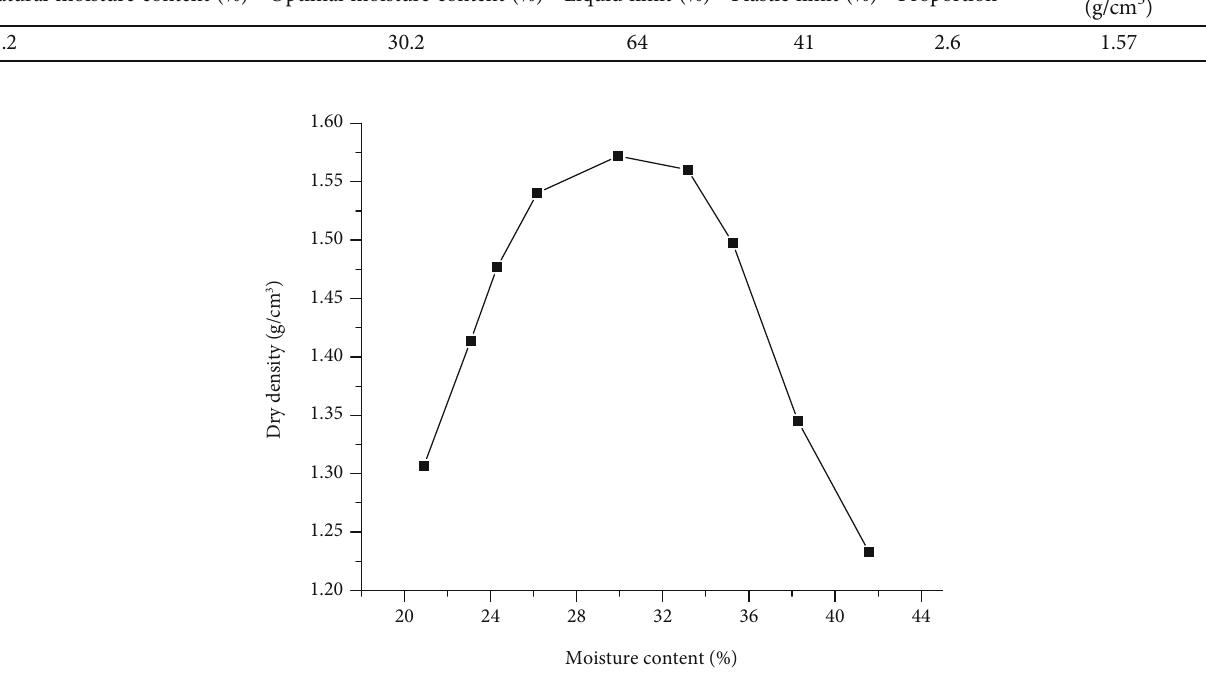
Figure 1: Dry density and moisture content curve of Guilin red clay.